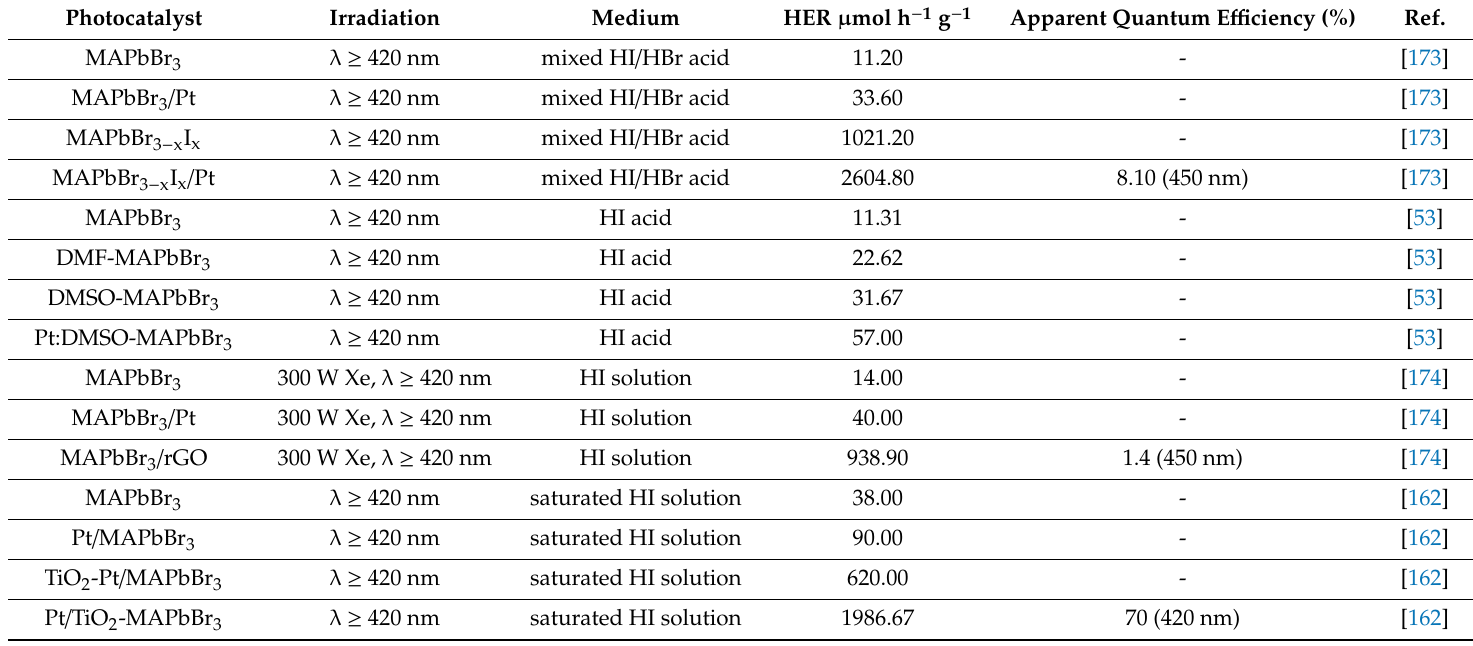
Table 3. Comparison of H 2 generation e ffi ciency of di ff erent hybrid organic–inorganic perovskites and their composites reported in the